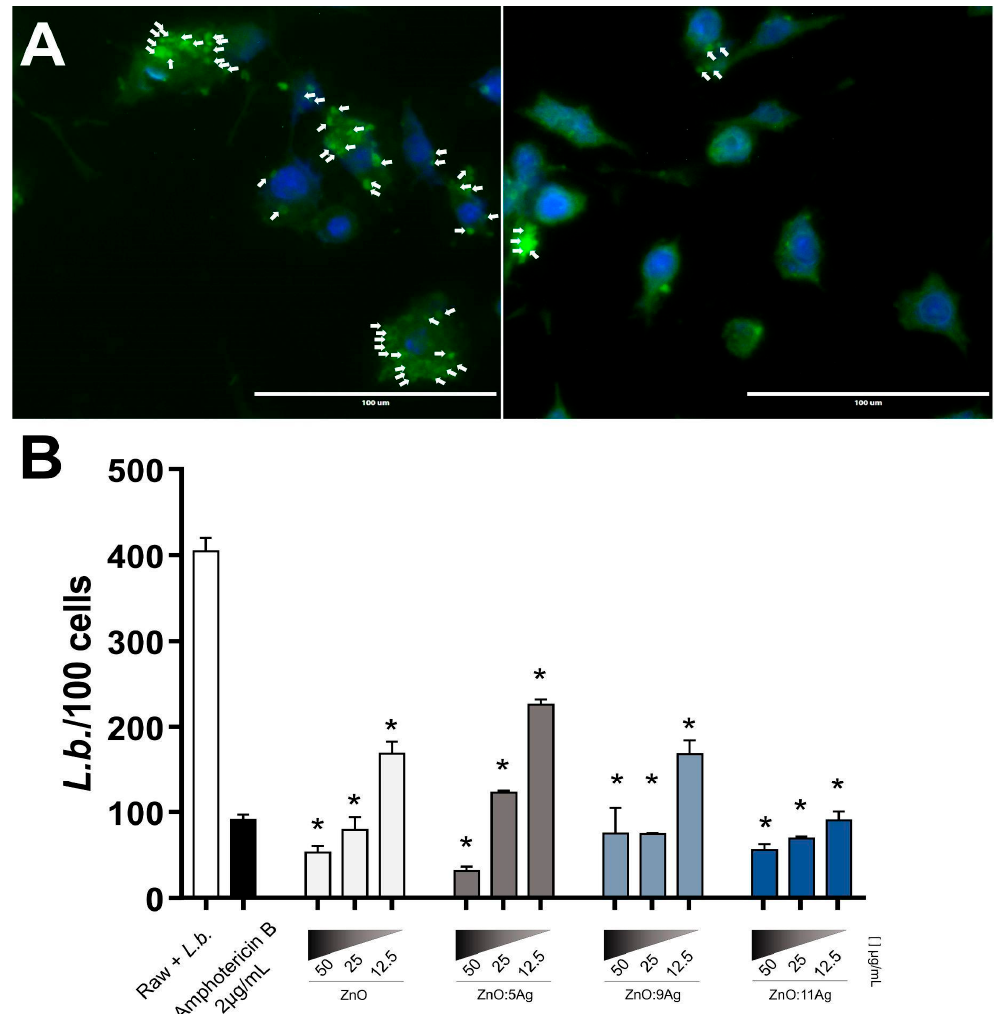
Figure 3. ZnO:9Ag and ZnO:11Ag NCPs reduce L. braziliensis intracellular amastigotes. ( A ) Intracellular L.b. amastigotes were evaluated by staining with DAPI (blue) and IgG anti- Leishmania +anti-IgG- FITC (green) and counting at least 200 cells/treatment. White arrows indicate intracelular amaastigores. Representative images: Left panel—Non-treated culture; Right panel—ZnO:11Ag— 50 μ g/mL. ( B ) RAW 264-7 were infected with L.b. (MOI 10:1) for 12 h and treated with different nanoformulations at doses of 50, 25 and 12.5 μ g/mL for 72 h. The results are expressed as the mean ± SEM. The Mann ‒ Whitney test was applied, and values of p < 0.05 (*) were considered significant when compared to non-treated cultures. Culture without treatment (medium). Cells treated with Amphotericin B (2 μ g/mL) were used as treatment control.